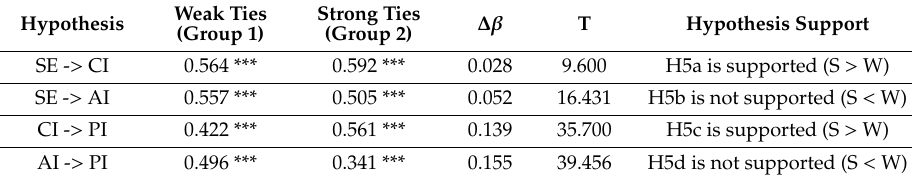
Table 6. Comparison between strong ties and weak